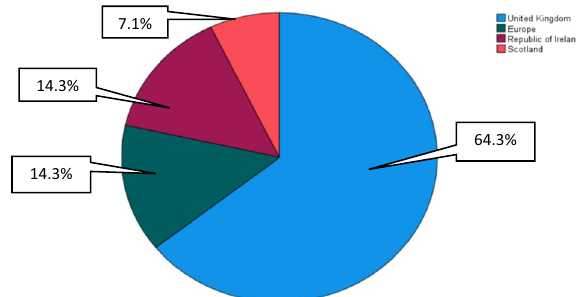
Fig. 4 What country of residence is your organization?. Source Own